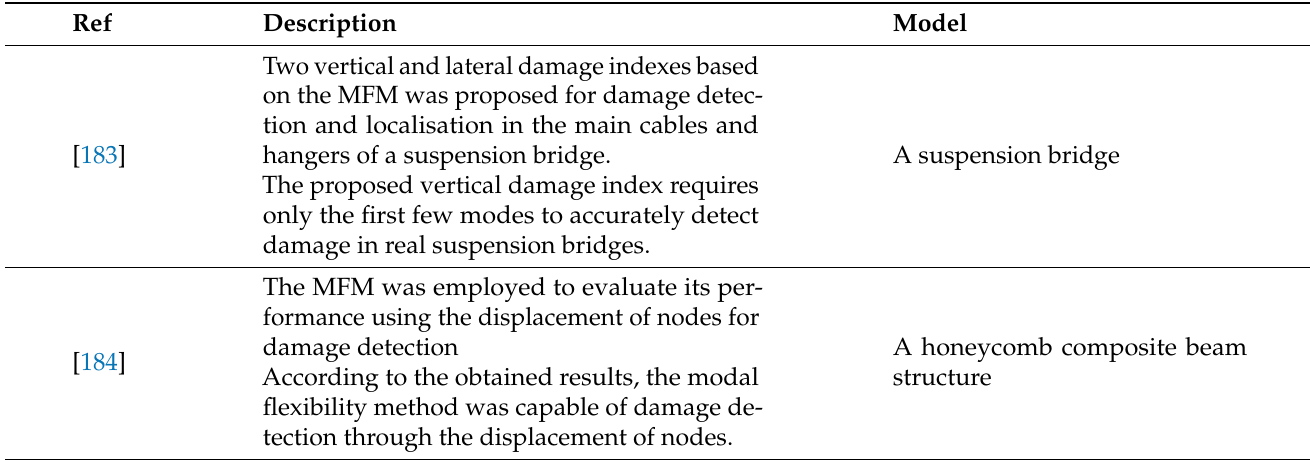
Table 13. Some recent developments using modal flexibility in damage detection of composite